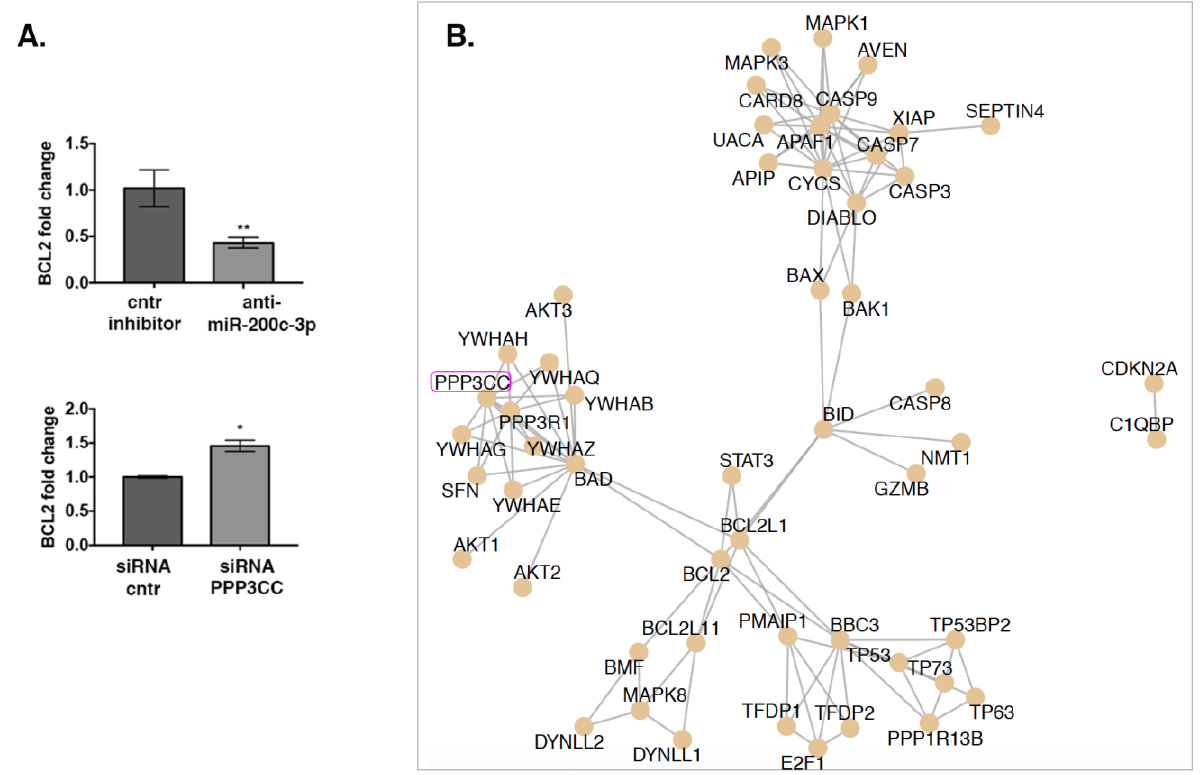
Figure 6. Downstream regulatory activity of PPP3CC on apoptosis. ( A ). Bcl-2 mRNA expression was evaluated through RT-qPCR at 144 h post-transfection. Upper graph: UWB 1.289 + BRCA1 cells were transfected with anti-miR-200c-3p and